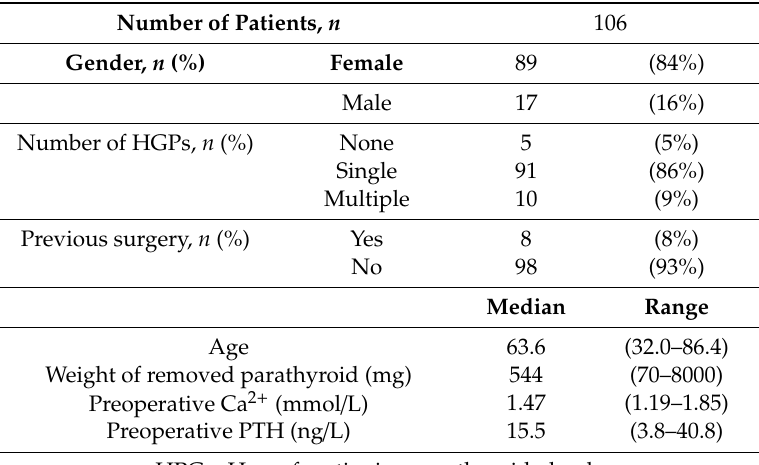
Table 1. Baseline patient characteristics.